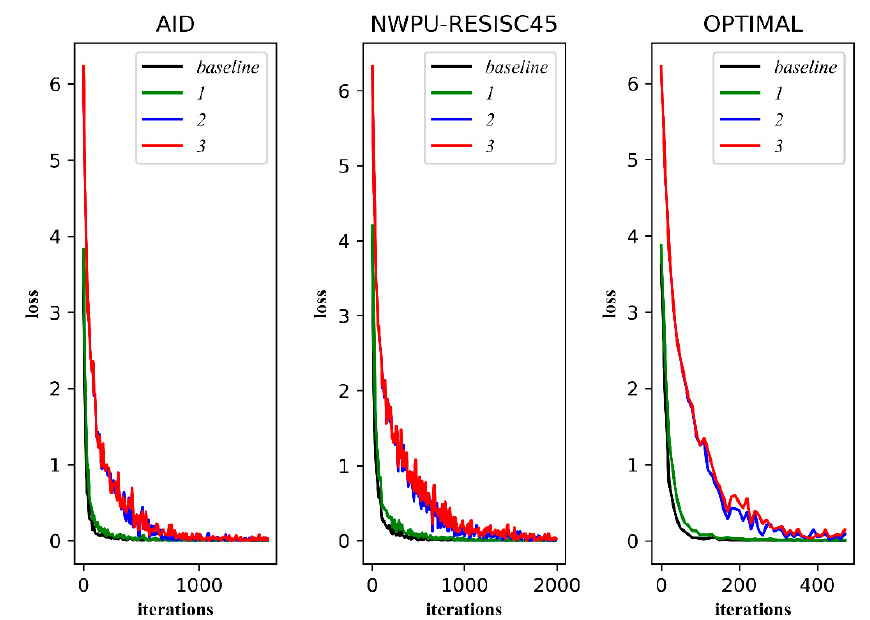
Figure 9. The transformation trend of the model’s loss. The horizontal axis is the number of iterations, and the vertical axis is the loss value.